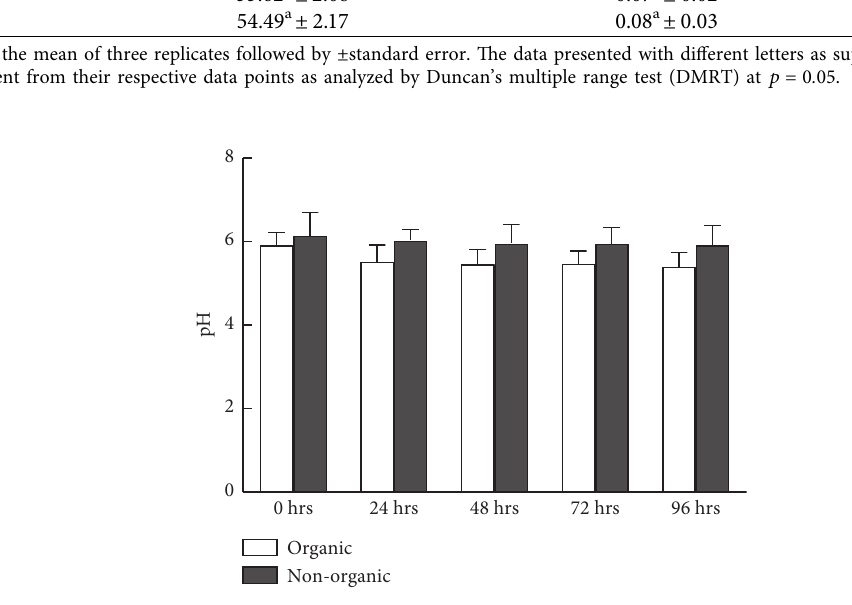
Figure 1: pH value of both organic and nonorganic vegetable soups at 0h, 24h, 48 h, 72h, and 96h. Each data point is the mean of triplicated data with ± SE. The bars are not significantly different from each other at p � 0 . 05 as evaluated by DMRT.